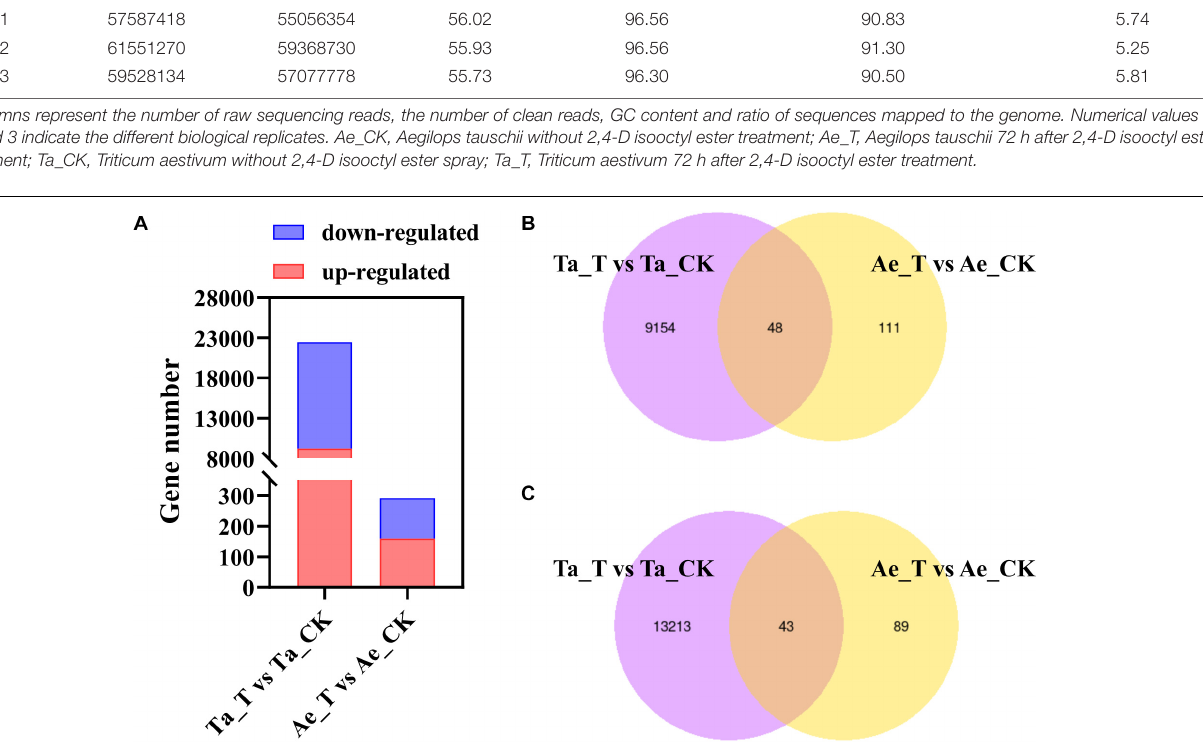
FIGURE 2 | Differentially expressed genes (DEGs) in T. aestivum and Ae. tauschii response to 2,4-D isooctyl ester. (A) Numbers of upregulated DEGs and downregulated DEGs. (B,C) Venn diagram of two comparison groups of upregulated DEGs (B) and downregulated DEGs (C) . Ta_T, T. aestivum with 2,4-D